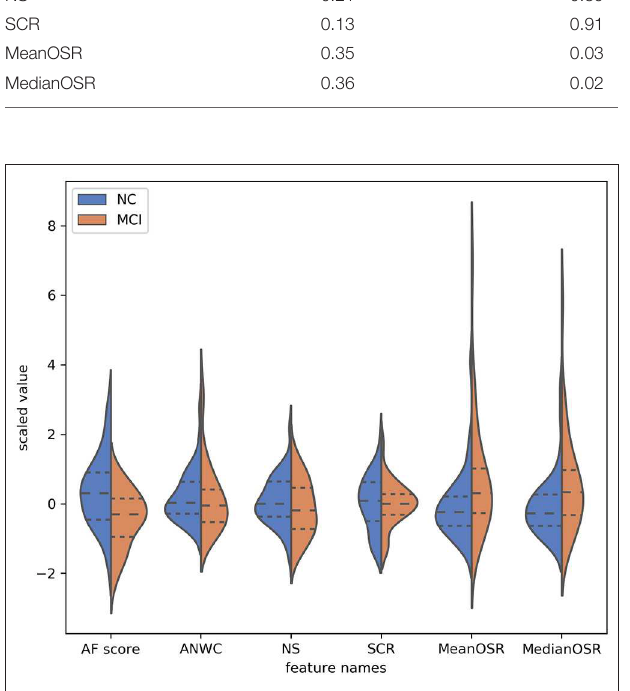
FIGURE 3 | Probability distribution of features (y-axis) selected by the feature selection algorithm. The dynamic range of features have been normalized according to the RobustScaler approach. The dotted line from left to right are 25 % quantile, 50 % quantile, and 75 %